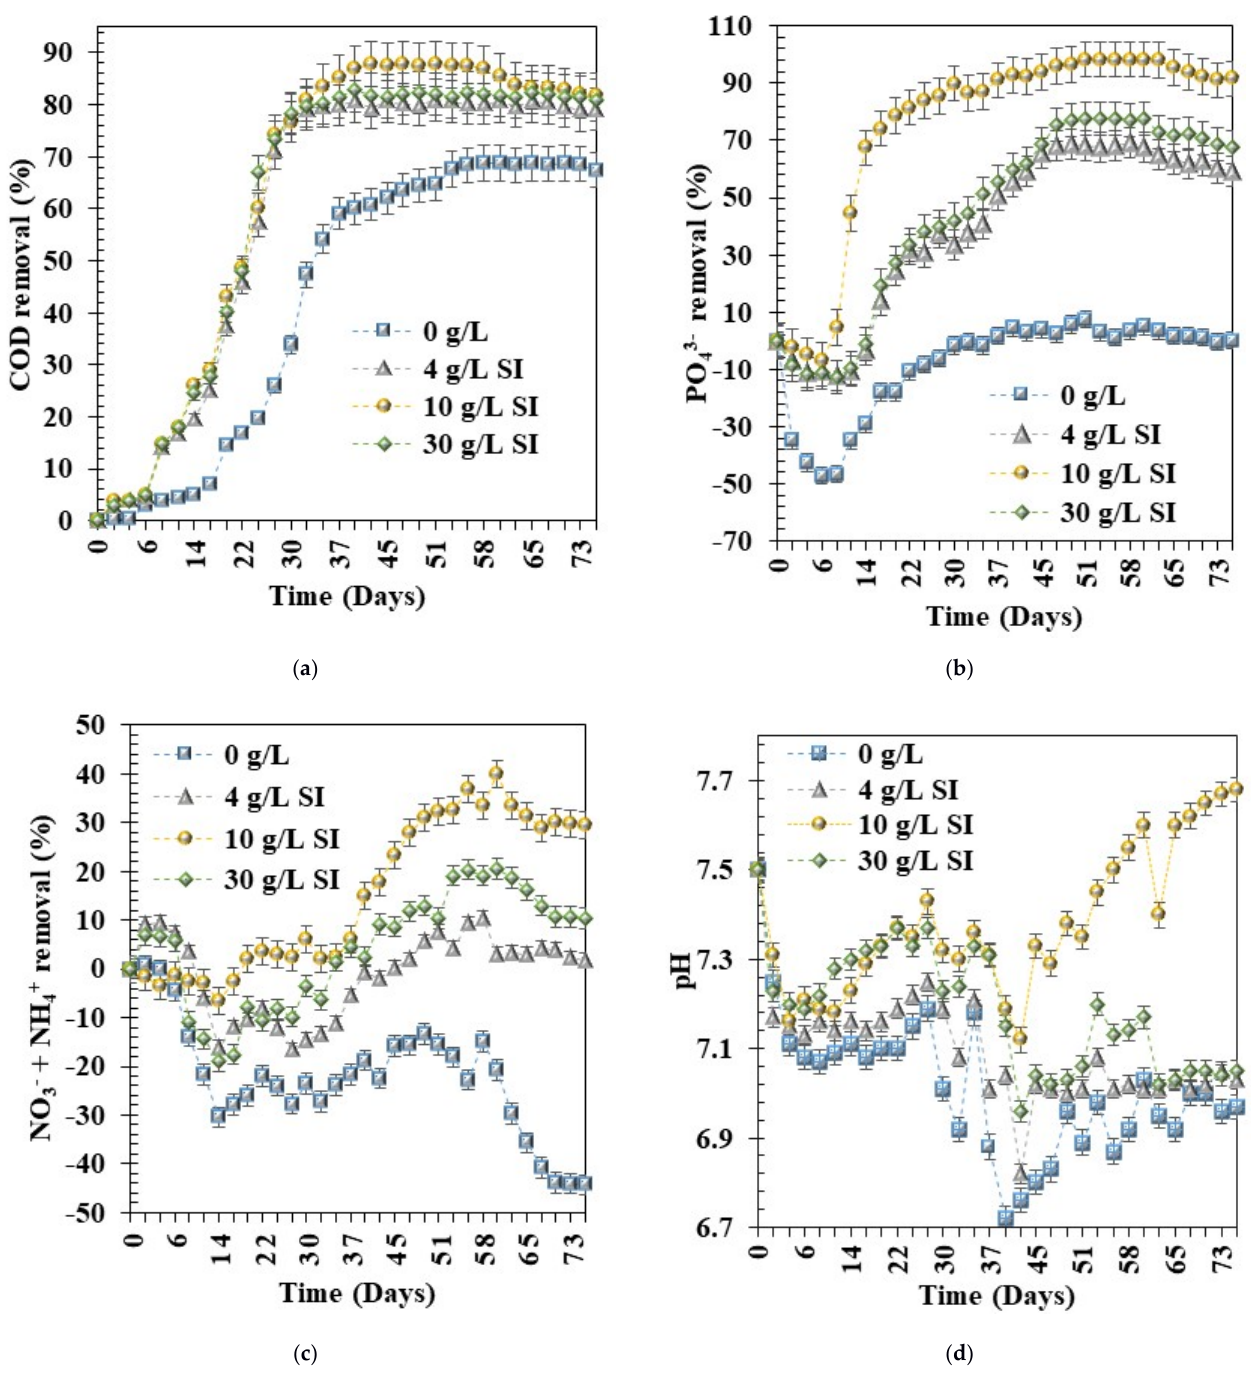
Figure 3. Comparison of the effects of varying SI materials dosages in pollutants removal efficiency. ( a ) COD removal; ( b ) PO 43 − removal; ( c ) NO 3 − + NH 4+ removal; ( d ) pH variations. SI materials’ dosages were 0 g, 4g/L, 10 g/L, 15 g/L and 30 g/L; Systems’ temperature, T = 37 ± 0.5 °C.